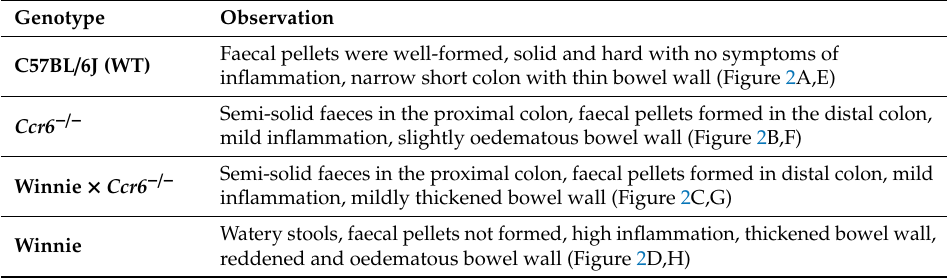
Table 3. Observations made of gross colonic morphological features after removal of colon. Genotype